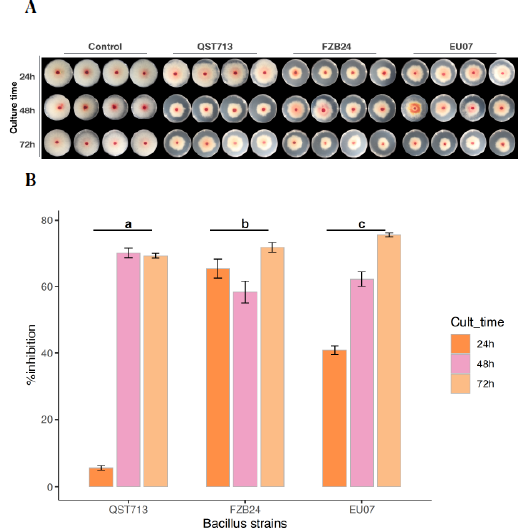
Figure 2. Normalised bacterial broths of Bacillus strains suppress fungal growth. ( A ). Fg -K1-4 growing on PDA/NA medium containing filtered and adjusted bacterial broths. The fungus was grown on PDA/NA medium in the presence of the 100 µL filtered and adjusted bacterial broths obtained from QST713, FZB24 and EU07 after 6, 24, 48 and 72 h of culture. Bacterial strains are shown at the top, left to right and by culture time on the left, top to bottom. ( B ) Percentage growth inhibition of the Fg -K1-4 by the Bacillus strains cultured at different times, filtered and adjusted. Broths adjusted to 100.0 µg/mL of proteins from filtered broths cultured at different times (24, 48 and 72 h). Data were from one independent experiment with four repeats and shown as the mean ± SE. The exper- iment was replicated three times with similar results. Bars clusters with different letters were sig- nificantly different according to Tukey’s Test (α < 0.05) following two-way ANOVA. n = 36.